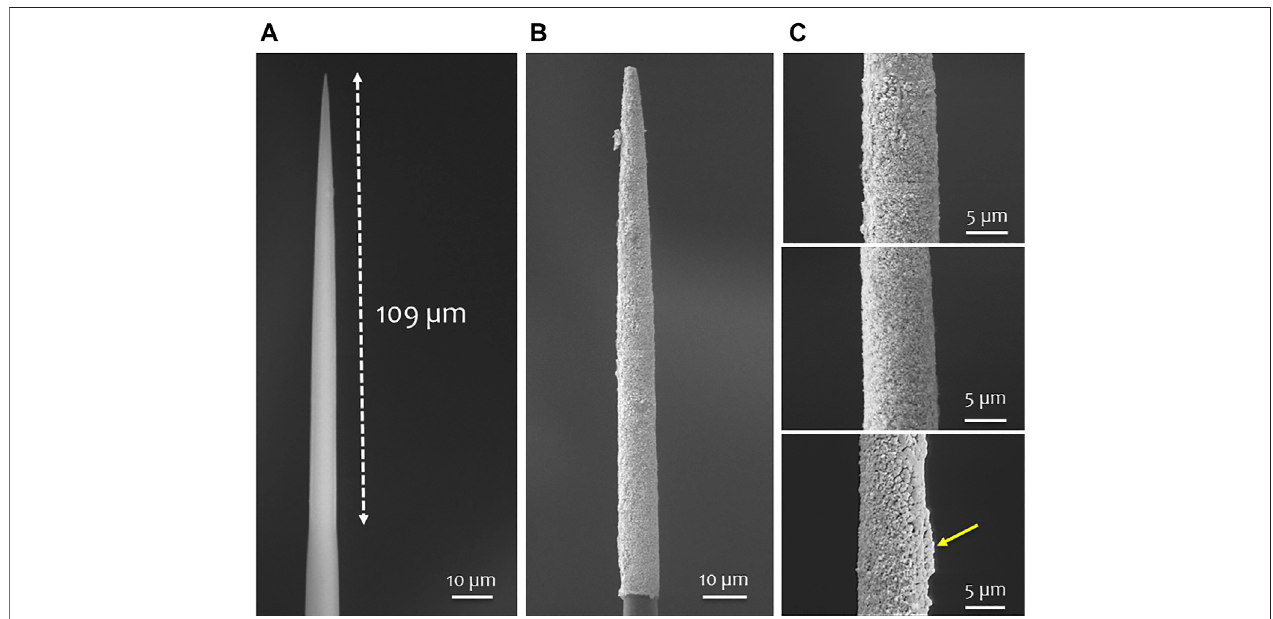
FIGURE 4 | SEM of PtIr-CF. SEM of a carbon fi ber with an exposed surface of 109 μ m before (A) and after the PtIr coating (B) ; (C) SEM images of three different PtIr-CF.